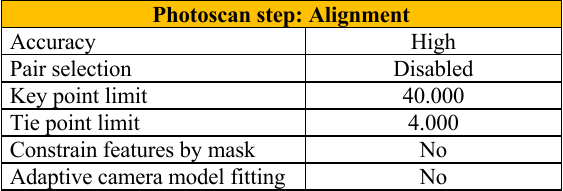
Table 5. Alignment settings for all datasets.